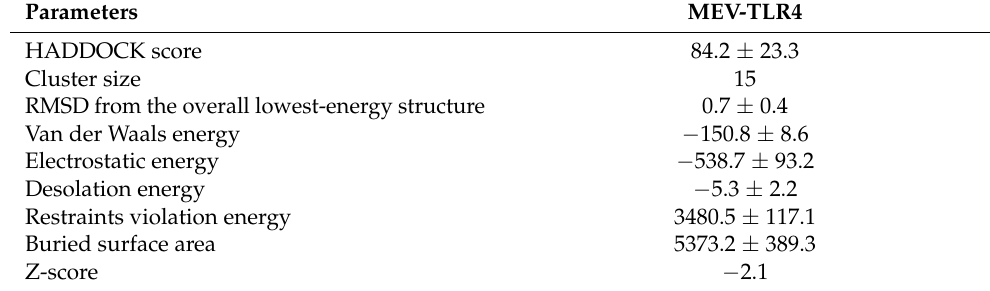
Table 4. Details of docking complex TLR-4 with MEV.